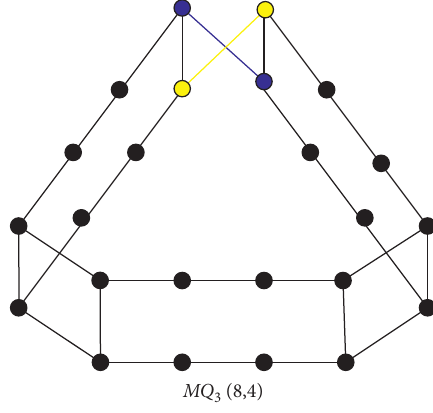
Figure 2: Graph MQ